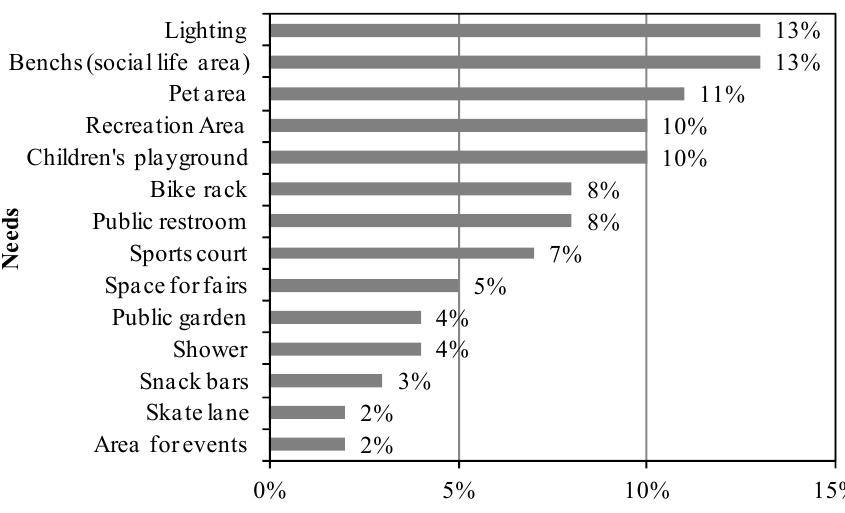
7 of 16 Figure 5. Minimum, maximum and average monthly rainfall in Florianópolis from 1996 to 2021 (based on [29]).